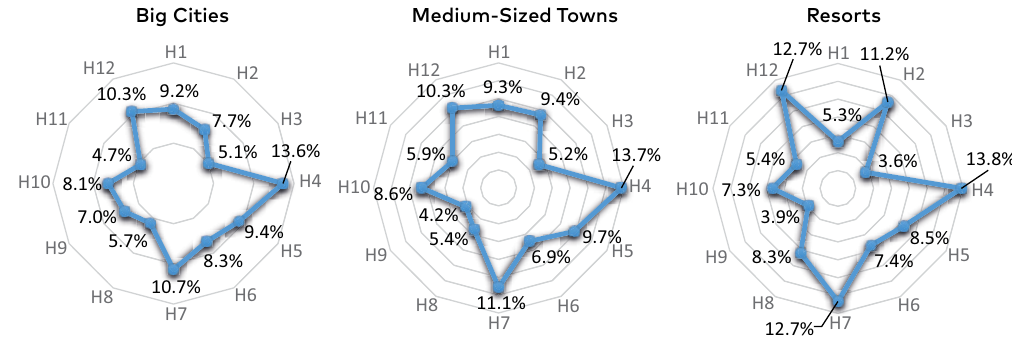
Figure 3. The significance of thematic areas in different